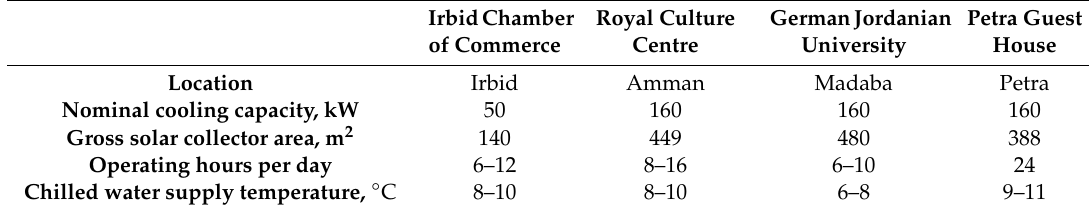
Table 1. An overview of the installed absorption